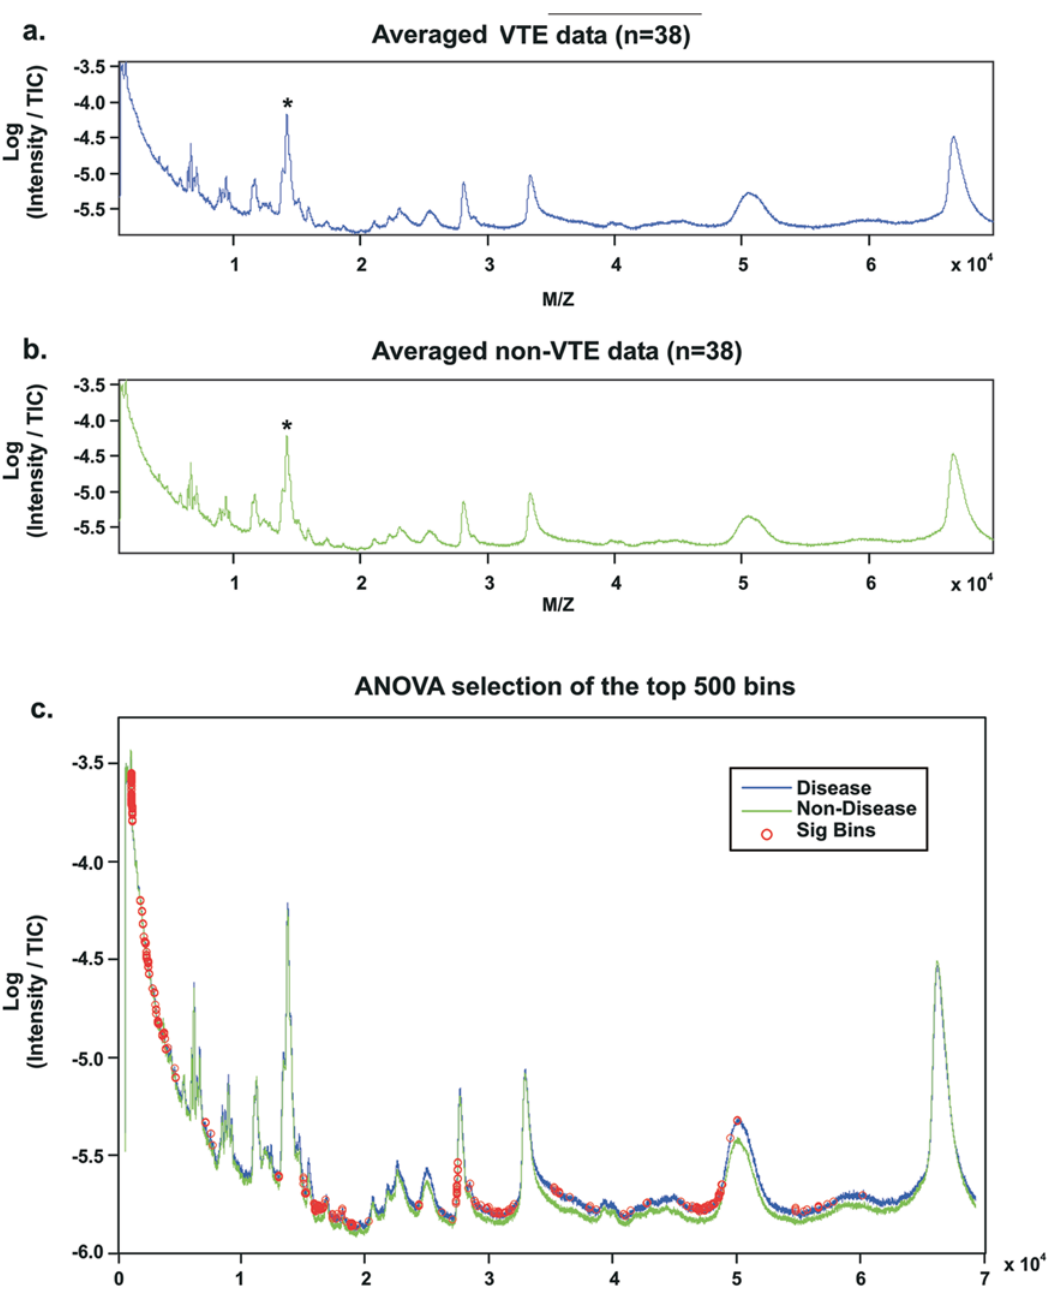
Figure 2. Direct MS of serum. Average spectra for patients with VTE (a) and without VTE (b) show differences in overall protein expression, with the internal spike protein denoted by an asterisk. The 500 signals selected by the ANOVA analysis are denoted by red circles, representing locations on the mass spectrum with differential protein expression between the two groups of patients (c).